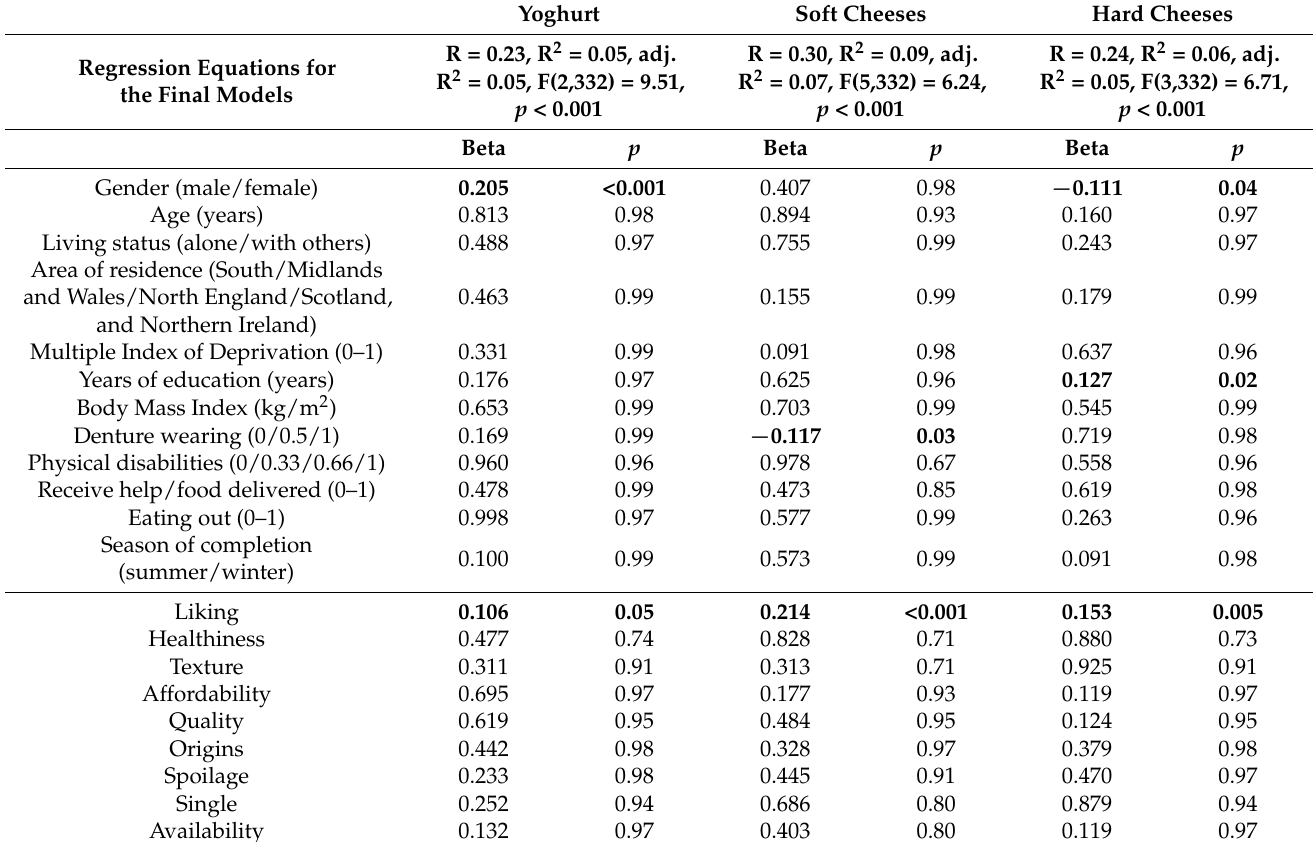
Table 2. Results of all regression analyses for dairy consumption (N = 347). Yoghurt Soft Cheeses Hard